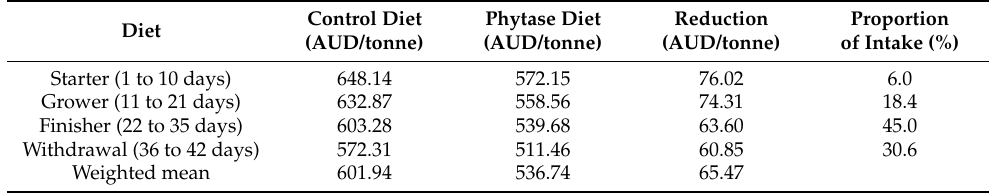
Table 5. Estimated impacts of phytase (1000 FTU/kg) matrix values on feed ingredient costs. Adapted from Moss et al.